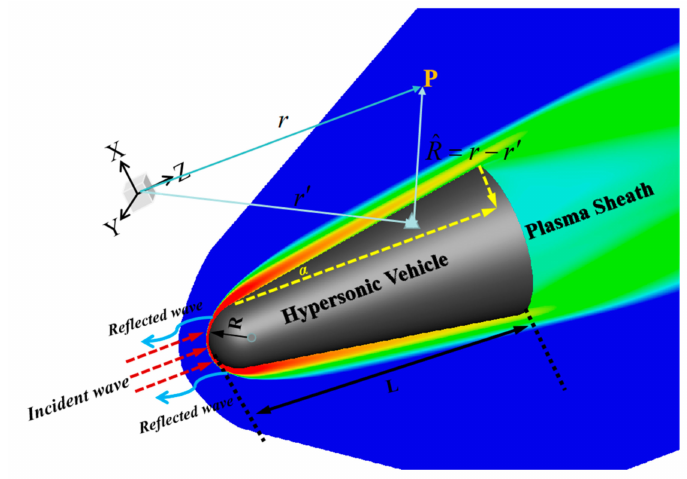
Figure 1. Geometric structure of hypersonic vehicle, R = 0.1524 m, L = 1.4474 m and α = 9